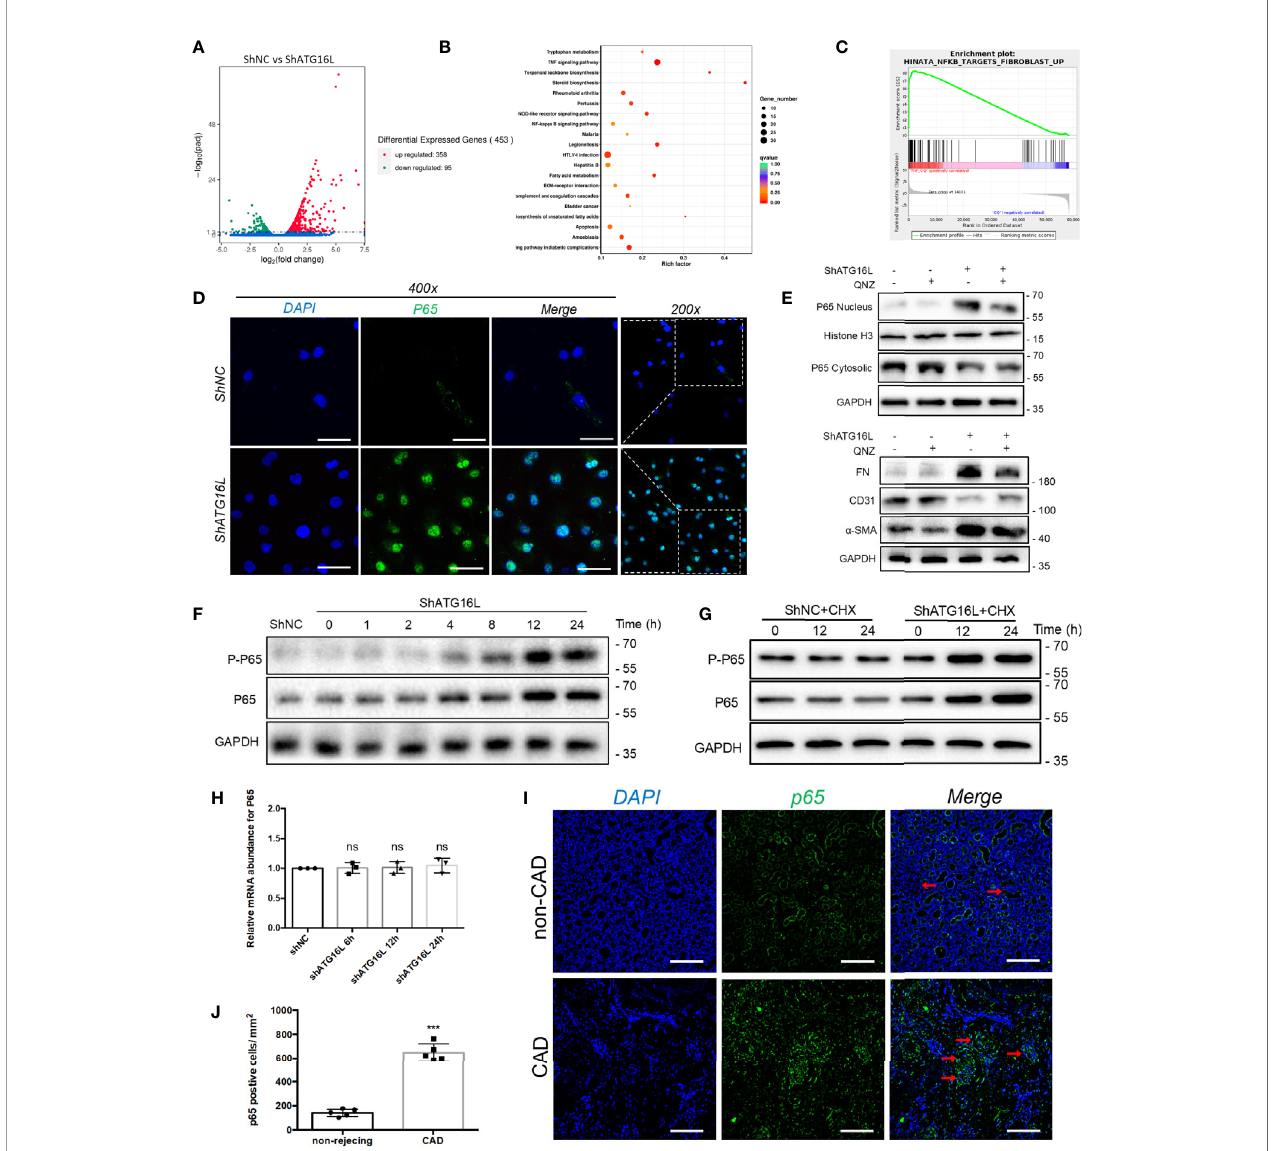
FIGURE 7 | NF- k B pathway activation and effect on EndMT in HRGECs after knockdown of ATG16L (A) The RNA sequencing results of differential genes in HRGECs transfected with shNC or shATG16L were plotted by volcano plot. (n=5) (B) KEGG pathway analyses of the top 20 KEGG enriched gene pathways. (C) GSEA plot of the correlation between knockdown of ATG16L and NF- k B enrichment gene signatures in the RNA sequencing results. (D) Representative images of p65 expression and distribution by indirect immuno fl uorescence staining assay in HRGECs transfected with shNC or shATG16L under confocal microscopy. Scale bar: 50 m m. (n=5) (E) Representative western blot results of the effects of NF- k B inhibitor (QNZ) on NF- k B nuclear translocation and EndMT markers (FN, a -SMA and CD31) expressions in HRGECs transfected with shATG16L or not. (n=5) (F) Representative western blot results of p65 and p-p65 (Ser536) expressions after knocking down ATG16L for different time. (n=5) (G) Representative western blot results of p65 and p-p65 (Ser536) expressions with CHX treatment for different time in shNC and shATG16L group. (n=5) (H) The mRNA levels of p65 in HRGECs transfected with shNC or shATG16L. (n=5, NS, not signi fi cant, vs. the shNC group, Student t test.) (I) Representative images of p65 expression and distribution in the non-CAD and CAD allograft renal tissues via indirect immuno fl uorescence staining assay (scale bar: 25 m m). (J) Semi-quantitative analysis results for indirect immuno fl uorescence staining assay of p65 in the non-CAD and CAD allograft renal tissue (n = 4, *** P < 0.001, vs. the non-CAD group, Student t